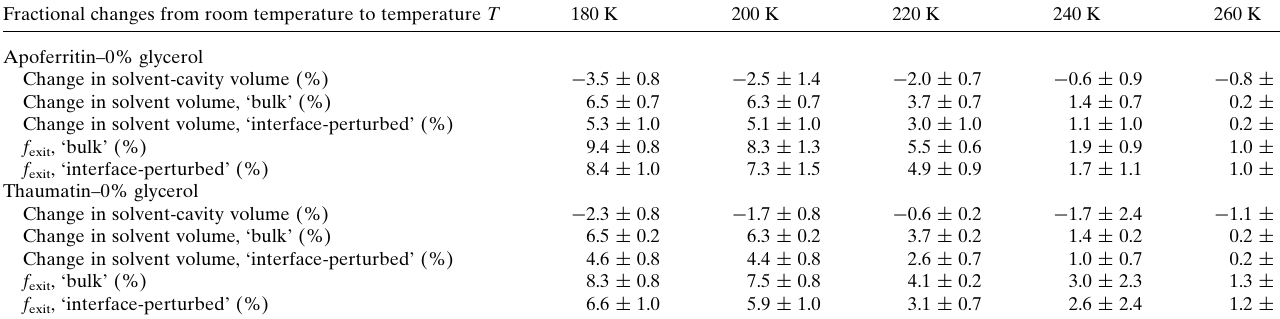
Table 1 Fractional changes in solvent-cavity volume and solvent volume (assuming bulk and interface-perturbed solvent contractions) on cooling from room temperature to each indicated temperature, and the fraction of solvent that must exit the unit cell, for apoferritin and thaumatin crystals calculated as described in Supporting Information Section S5. The volume fractions of the room-temperature unit cell occupied by solvent cavities, determined from structural models using the program map_channels , are 63.4 and 60.2% for apoferritin and thaumatin, respectively. Fractional changes from room temperature to temperature T 180